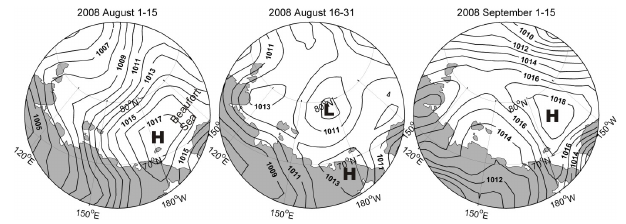
Fig. 4. Average Sea Level Pressure (SLP) during first half of August, second half of August and first half of September 2008, from National Center for Environmental Prediction (NCEP) data.